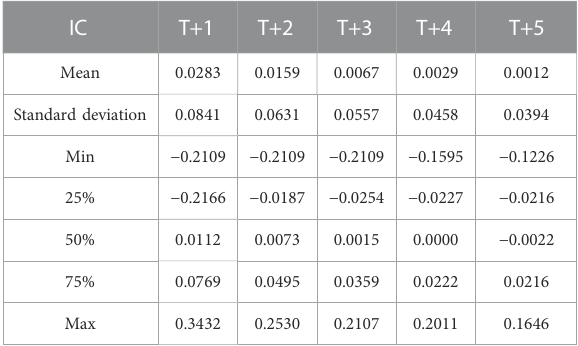
TABLE 1 Correlation results between the collective investor attention and the stock return. It shows the normal IC statistic distribution between the collectiveinvestorattentionondayTandthereturnondaysT+1,T+2,T+3, T+4, and T+5, including mean, standard deviation, minimum, 25% quantile, 50% quantile, 75% quantile, and